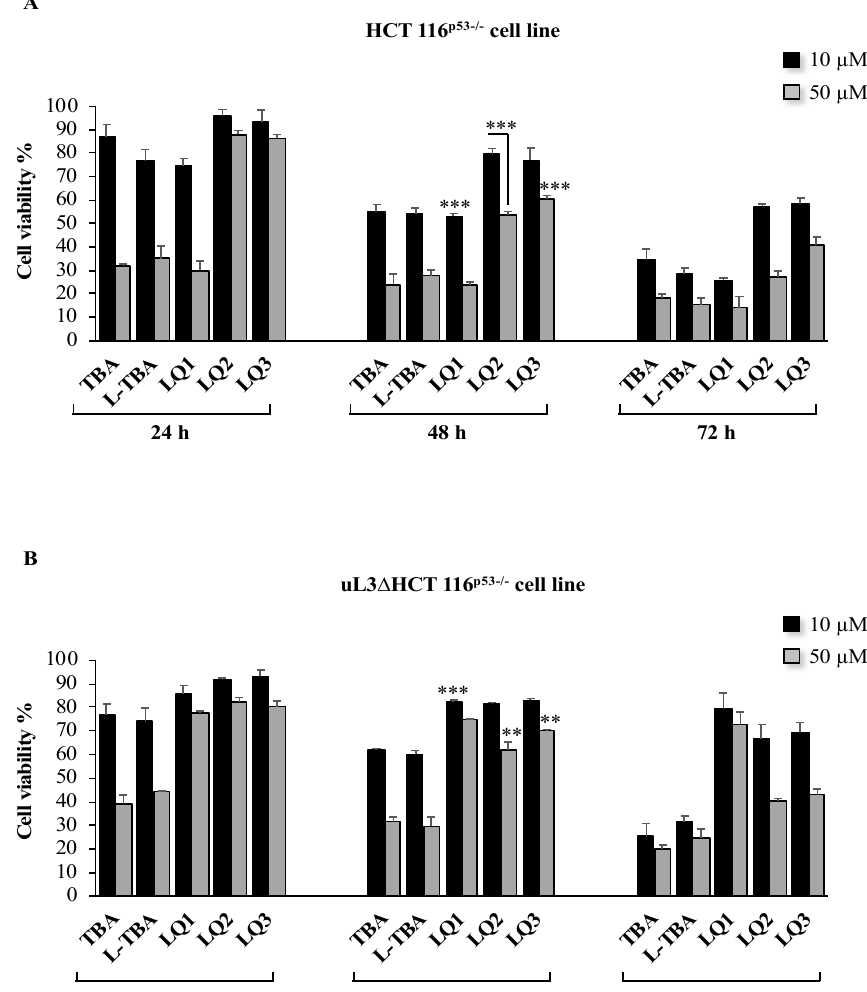
Figure 2. Cytotoxic activity of L-TBA and its derivatives on HCT 116 p53 − / − ( A ) and uL3 ∆ HCT 116 p53 − / −